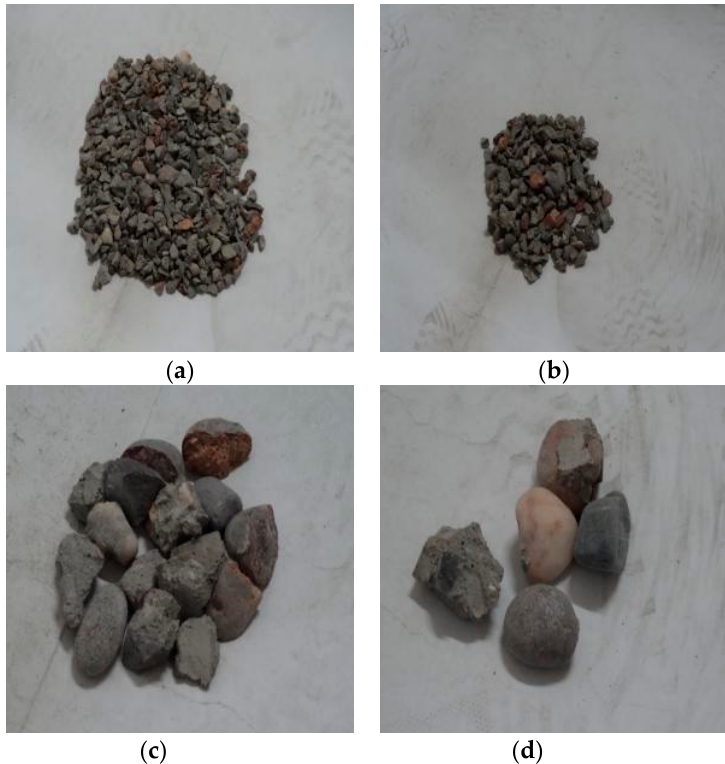
Figure 6. Concrete particles after slow heating up to 400 °C and sieving (impact speed 8.6 m/s), water cooling. ( a ) 5 mm (39.2%); ( b ) 10 mm (33.47%); ( c ) 16 mm (9.07%); ( d ) 20 mm (18.15%).